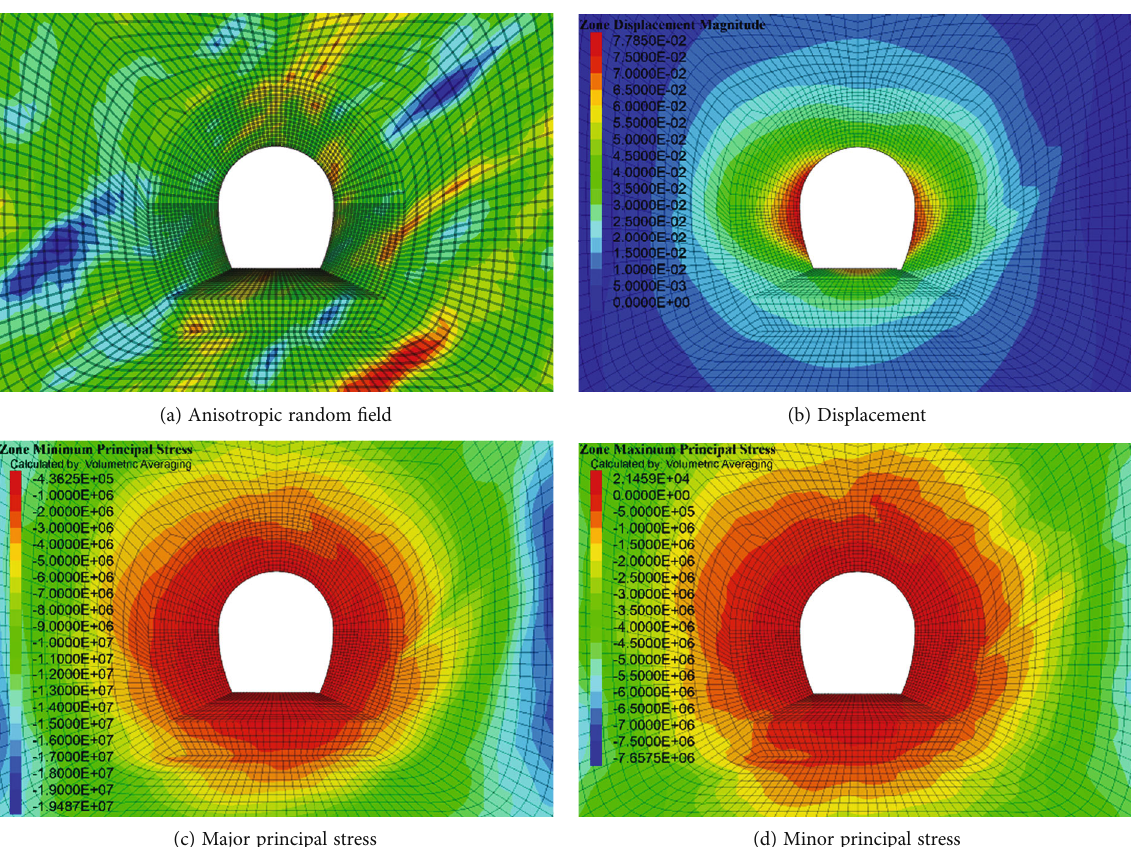
Figure 12: Analysis of cavern excavation results with 45 ° anisotropic fi